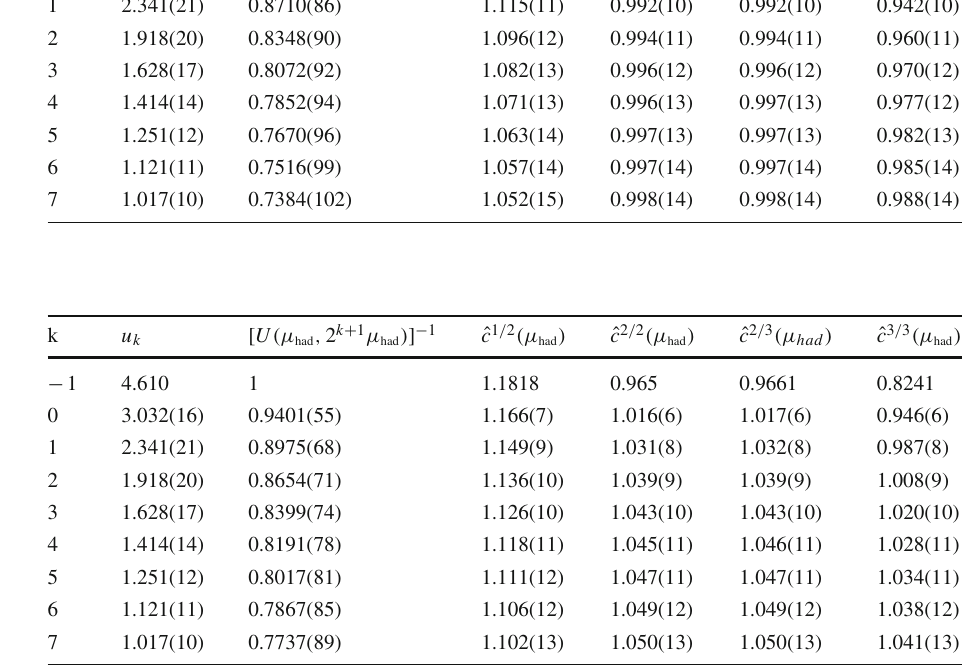
Table 17 Non-perturbative N f = 2 running in the scheme α = 0. (Our best result ˆ c 2 / 3 (μ ) is stressed.) had